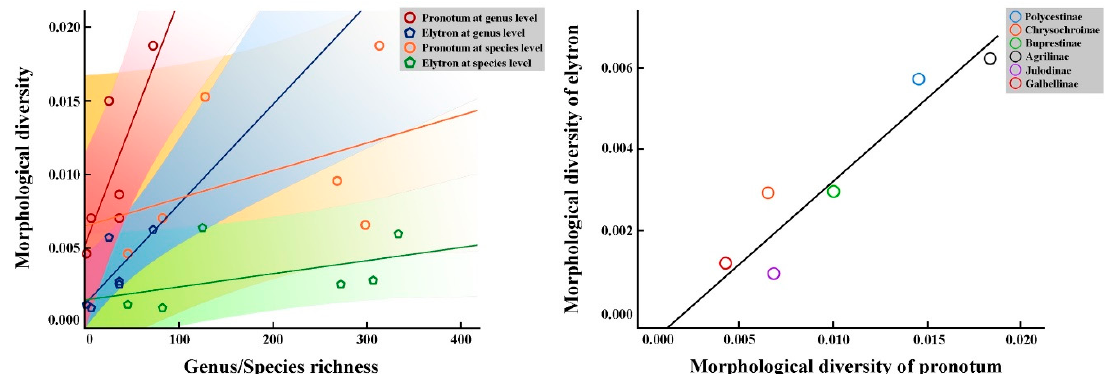
Figure 5. Results of correlation analyses of test subfamilies of Buprestidae. ( A ). Relationships between morphological diversity and genus/species richness. Four sets of measurements were obtained: pronotum test at genus level; pronotum test at species level; elytron test at genus level; elytron test at species level. ( B ). Correlation between the morphological diversity of the pronotum and elytron.